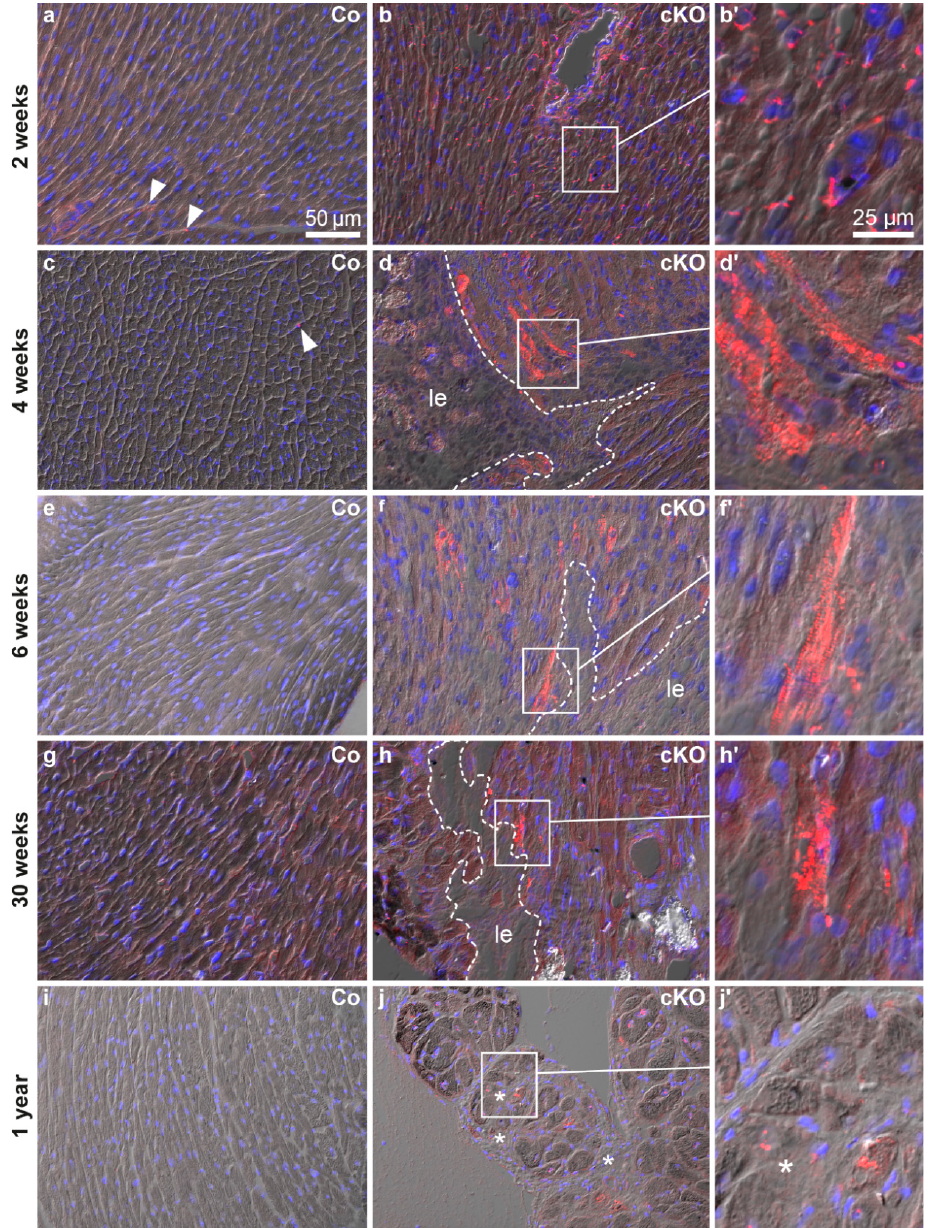
Figure 2. The ubiquitin binding protein SQSTM1/p62 is expressed in a similar temporal and spatial pattern as LC3 (compare with Figure 1). All micrographs are taken from left ventricles. The images show the merged pictures of the blue channel (nuclear Hoechst 3342 stain), the red channel (immunohistochemical detection of SQSTM1/p62 protein) and differential interference contrast. Left column: Dsg2 flox(E4 − 5 ) control myocardium (Co, a,c,e,g,i ); middle and right columns: Dsg2 cKO myocardium (cKO). SQSTM1/p62-positive vacuoles are scarce in the myocardium of wild-type mice of all ages (arrowheads; also refer to Figure S5), whereas abundant dot-shaped SQSTM1/p62 staining occurs in the ventricular myocardium of Dsg2 cKO mice in an age- and topology-dependent fashion. Cardiomyocytes with perinuclear SQSTM1/p62-positive dots are detectable in 2 week-old Dsg2 cKO hearts ( b , b ′ ). Cardiomyocytes containing vast amounts of SQSTM1/p62-positive granules appear in the vicinity of maturing fibrotic scars (le; dotted lines) at the age of 4–6 weeks ( d , d ′ , f , f ′ ). Such strongly SQSTM1/p62-positive cardiomyocytes next to lesions or interstitial fibrosis (le, *, respectively) are less numerous in Dsg2 cKO mice at 30 weeks and 1 year ( h , h (cid:48) , j , j (cid:48) ). Scale bars: 50 µ m in ( a ) (same magnification in entire left and middle columns); 25 µ m in ( b (cid:48) ) (same magnification in entire right